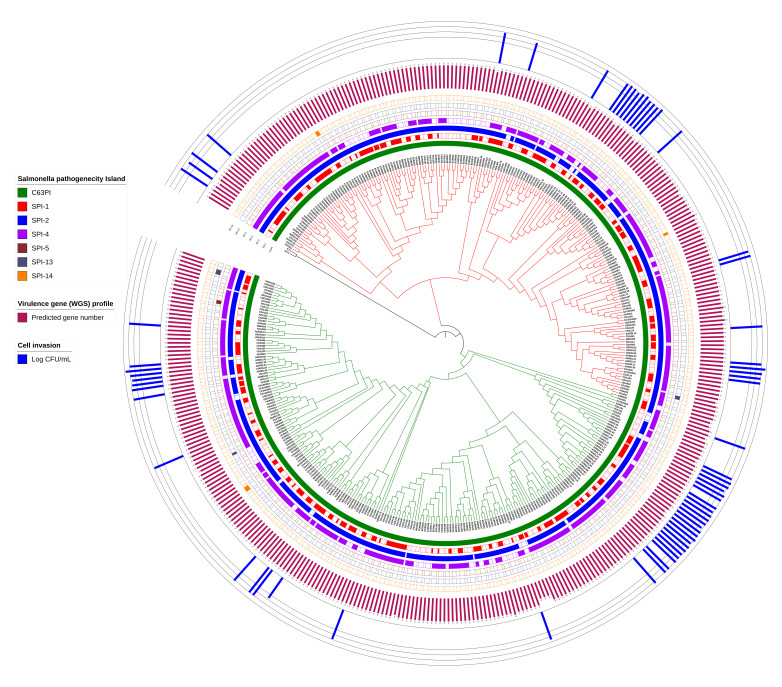
Virulence map of
Salmonella ser. Mbandaka. Screening of genome assemblies was performed to predict the
Salmonella pathogenicity islands (SPIs) and virulence factors. A cladogram of the MCC tree rooted to KY1 is shown at the center. Tree branches are colored to visualize the two major groups. The presence (dark color) of different SPIs is shown as different circles around the tree. The number of virulence factors predicted per genome (red) and the number of colony forming units (CFUs) that invaded Caco2 cells (blue) by the representative set of newly sequenced isolates are shown in different circles of simple bar charts. Figure was generated using iTOL v.4.3.2
19.